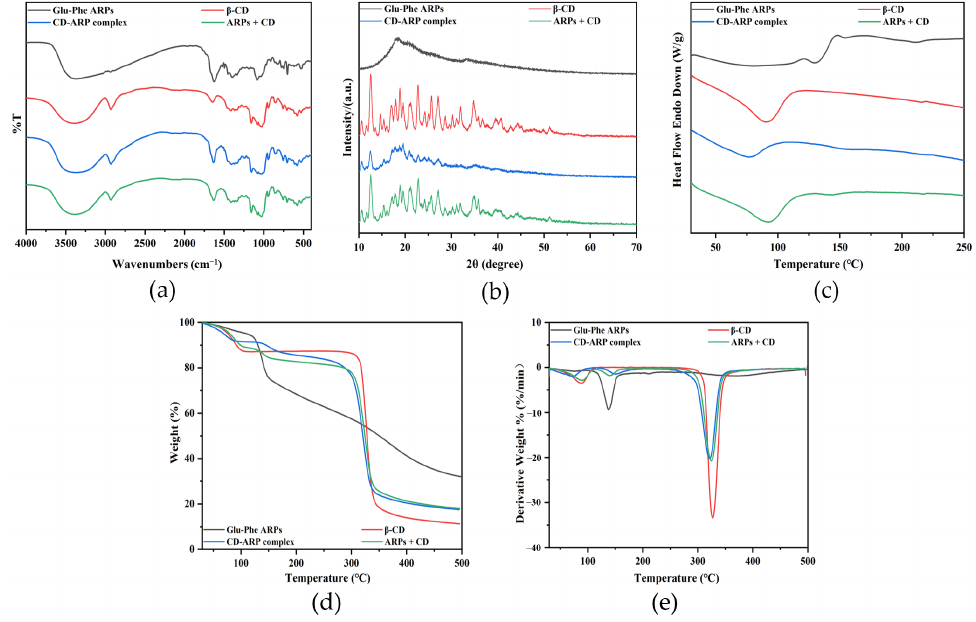
Figure 2. ( a ) FT-IR spectra, ( b ) XRD patterns, ( c ) DSC curves, ( d ) TG and ( e ) DTG curves of Glu-Phe ARPs, β -CD, CD-ARP complex and ARPs + CD.